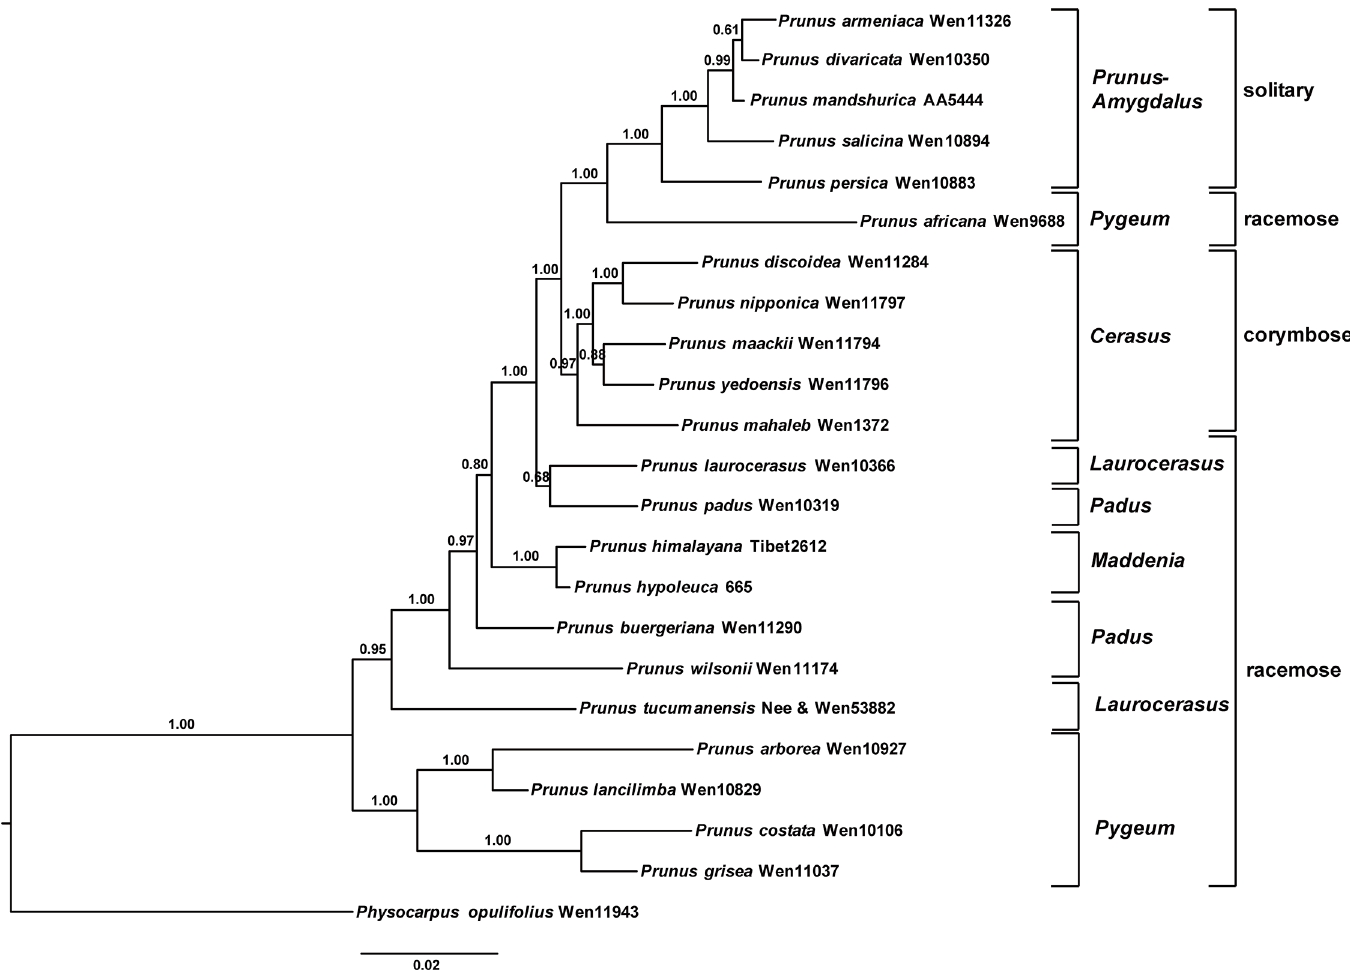
Fig 5. The 50% majority-rule consensus tree of Bayesian analysis inferred from the combined At103 and ITS sequences of Prunus . Bayesian posterior probabilities are shown above the branches.